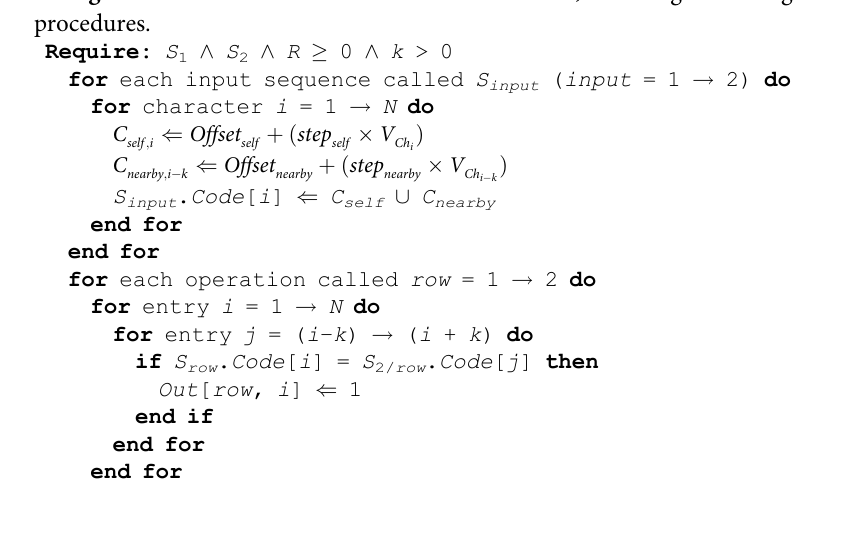
Algorithm 1 Pseudo-code of the HELIOS method , including the coding and alignment